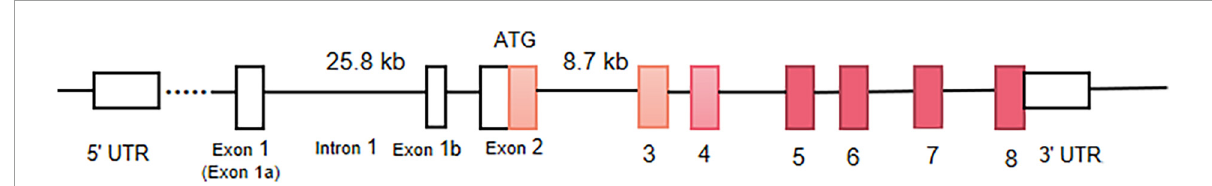
FIGURE1 The human IL-33 gene. The molecular weight of human IL-33 is about 18 kDa, and its gene span is > 42 kb. The main promoter of human IL-33 mRNA is upstream of the untranslated exon. The human IL-33 -encoding gene contains eight exons. Exon 1b may replace the promoter. There are CAD related SNPs in promoter and intron 1 regions. Previous studies have reported the absence of splicing variants on exons 3/4/5/8, which may lead to the production of spliced IL-33 proteins.